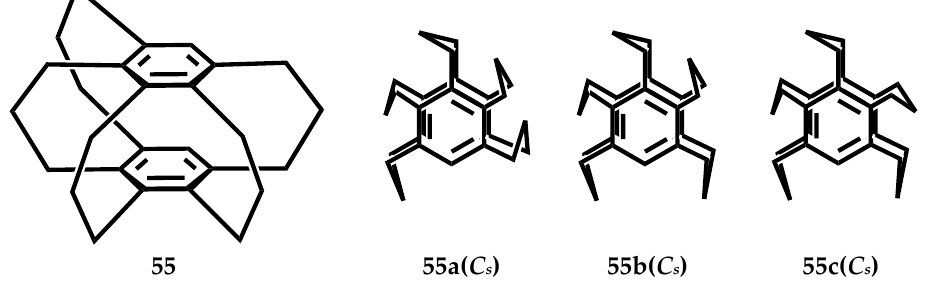
Figure 25. The stable conformers of 55a , 55b and 55c of the [3 5 ]CP 55 .